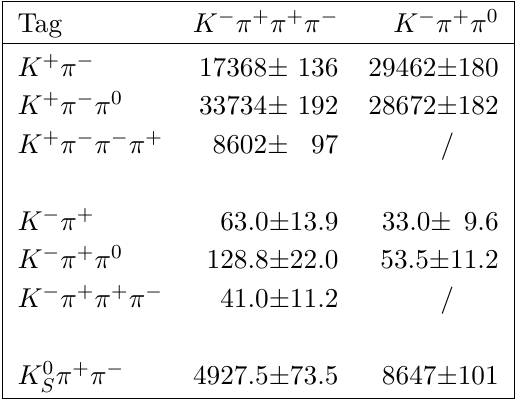
π + π − tagged events. The uncertainties S